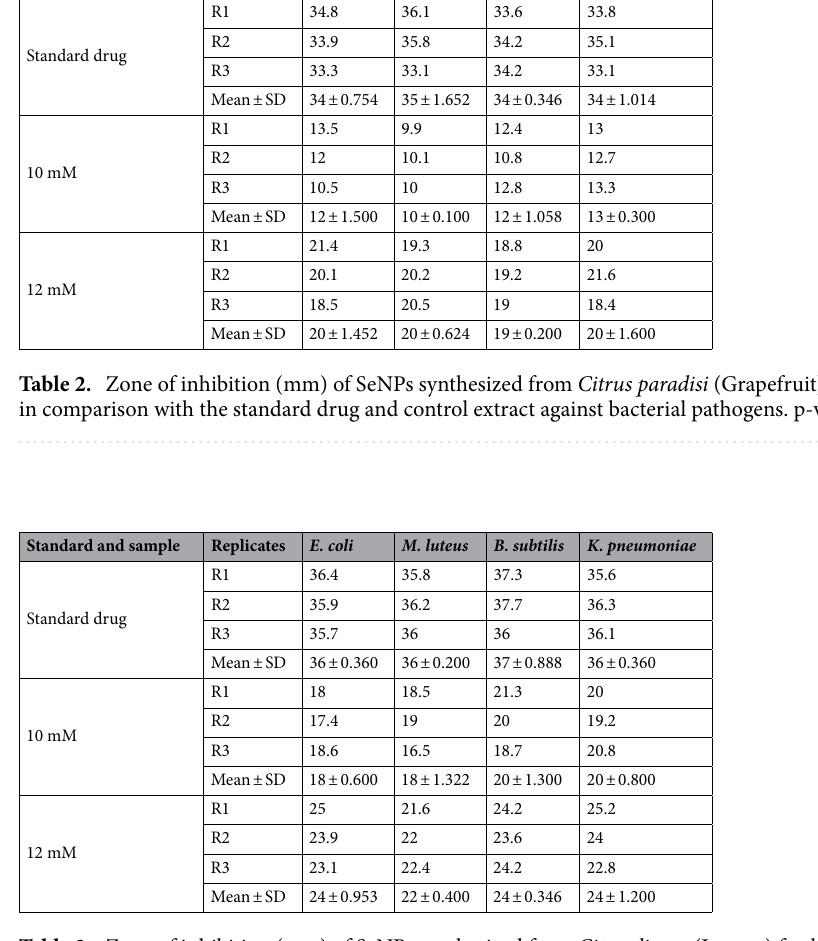
Table 3. Zone of inhibition (mm) of SeNPs synthesized from Citrus limon (Lemon) fresh juice extract in comparison with the standard drug and control extract against bacterial pathogens. p-value < 0.05.